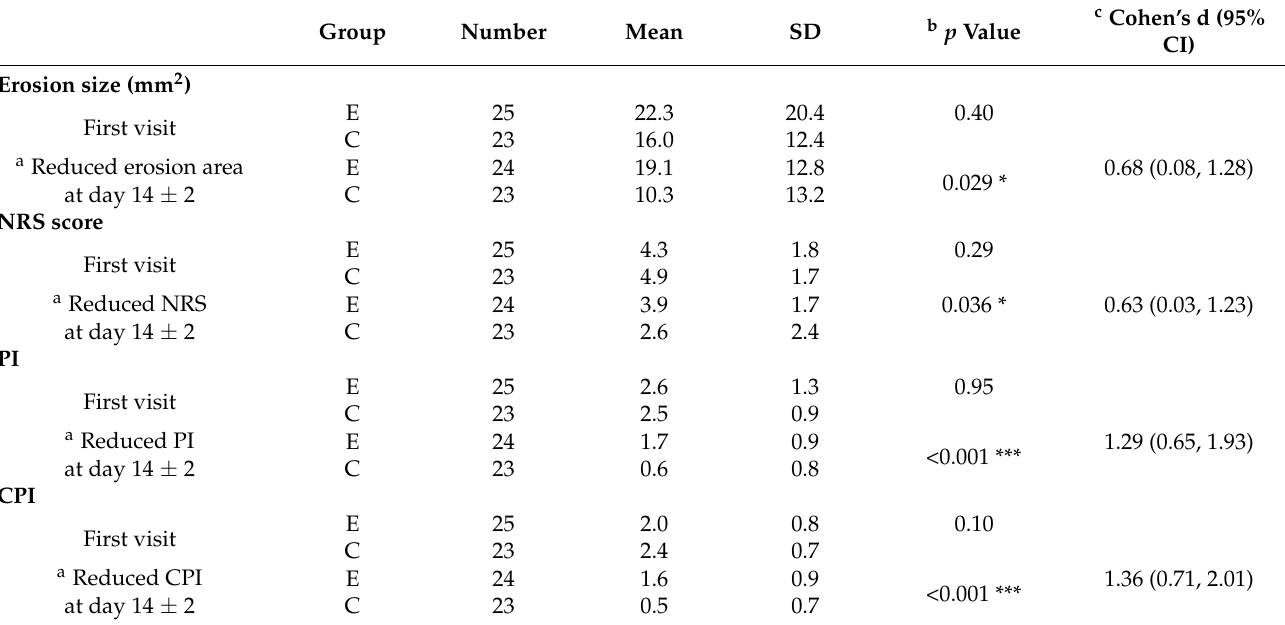
Table 3. Comparison of erosion size, NRS score, PI, and CPI between the two groups at the first visit and 14 ± 2 days after the first visit. Group Number Mean SD b p Value